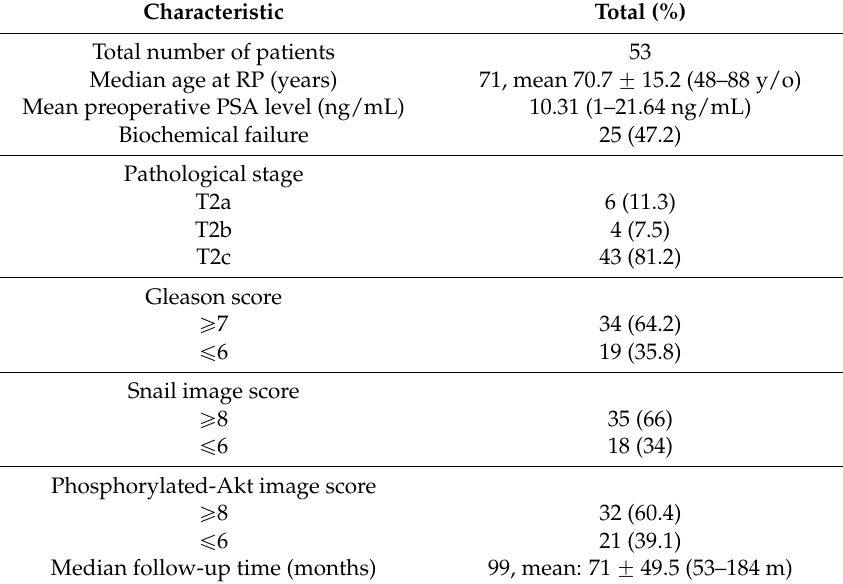
Table 1. Characteristics of prostate cancer (PCa) patients at the pT2 stage who underwent a radical prostatectomy (RP).